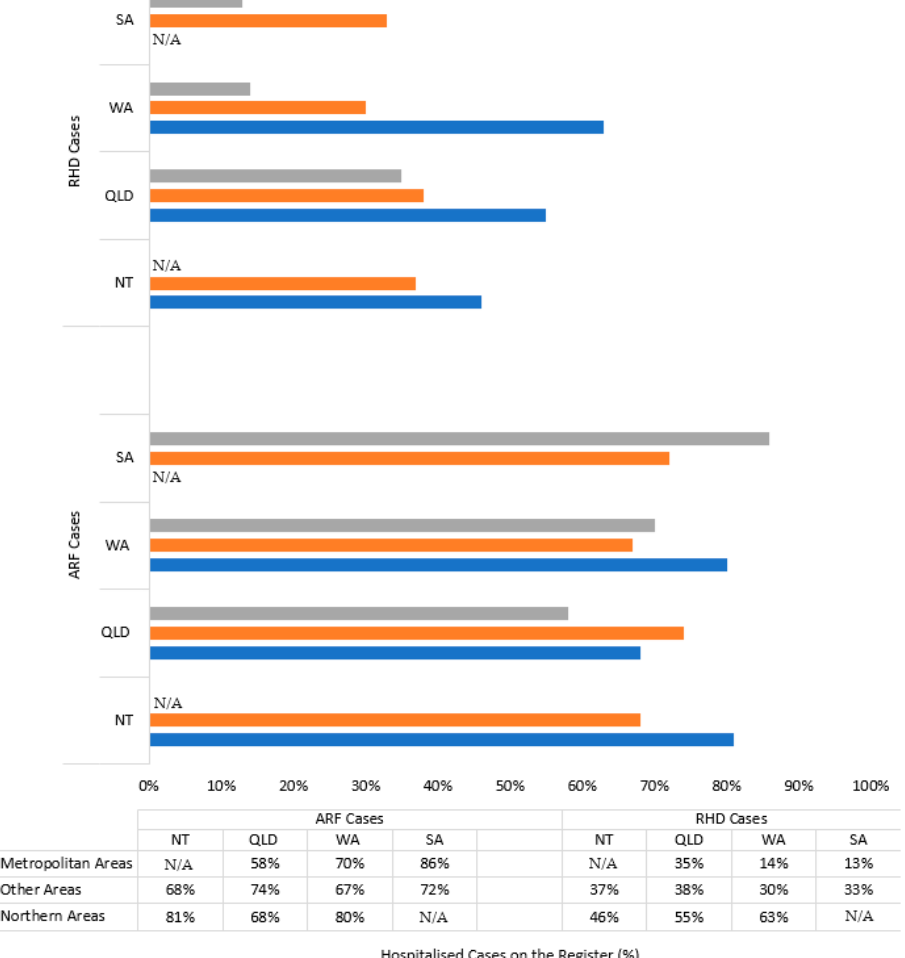
Figure 3. Percentage of hospital diagnosed acute rheumatic fever (ARF) and rheumatic heart disease (RHD) cases recorded on ARF/RHD registers for Indigenous cases by jurisdiction and